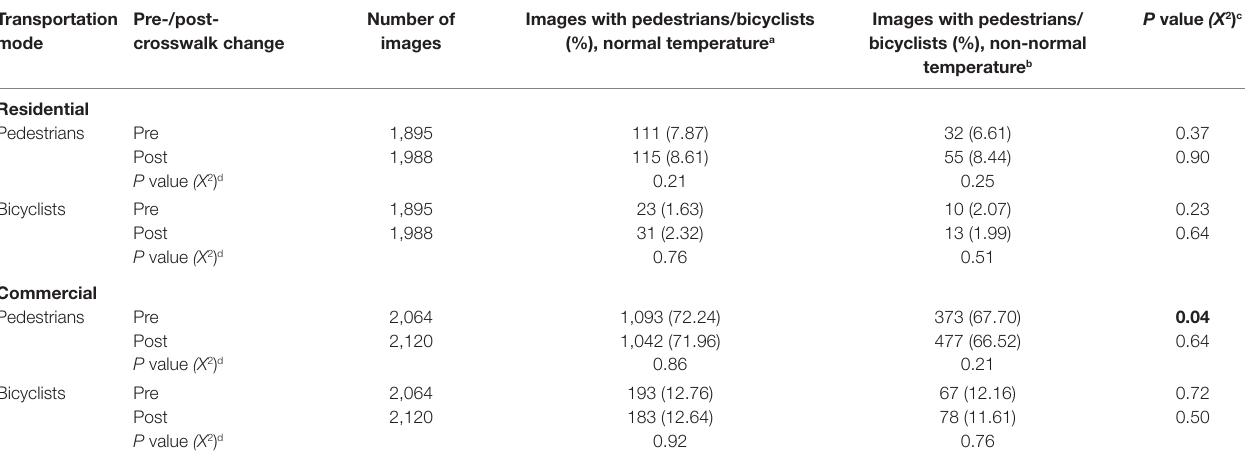
TaBle 3 | number of images with pedestrians and bicyclists before and after crosswalk enhancement, in normal versus non-normal temperatures. Transportation